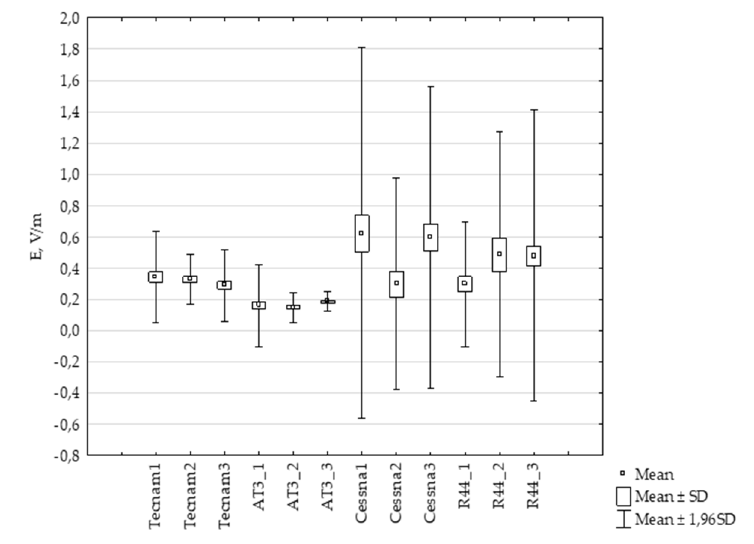
Figure 16. Box plots of measurements of the electric component of electromagnetic fields.